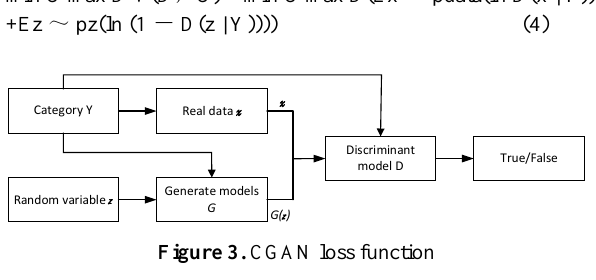
Figure 3. CGAN loss